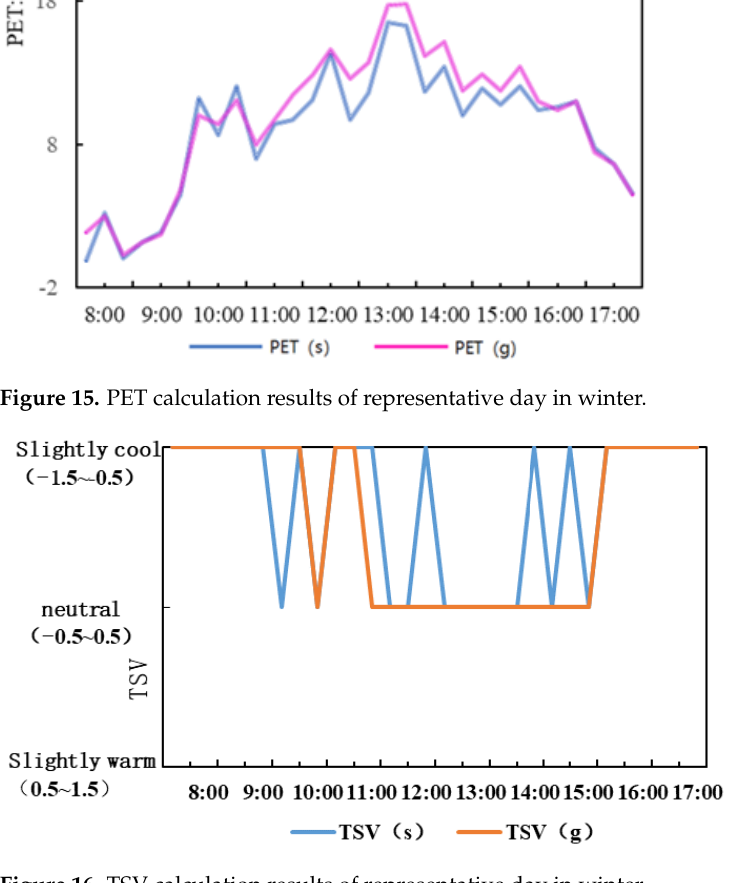
Figure 16. TSV calculation results of representative day in winter.